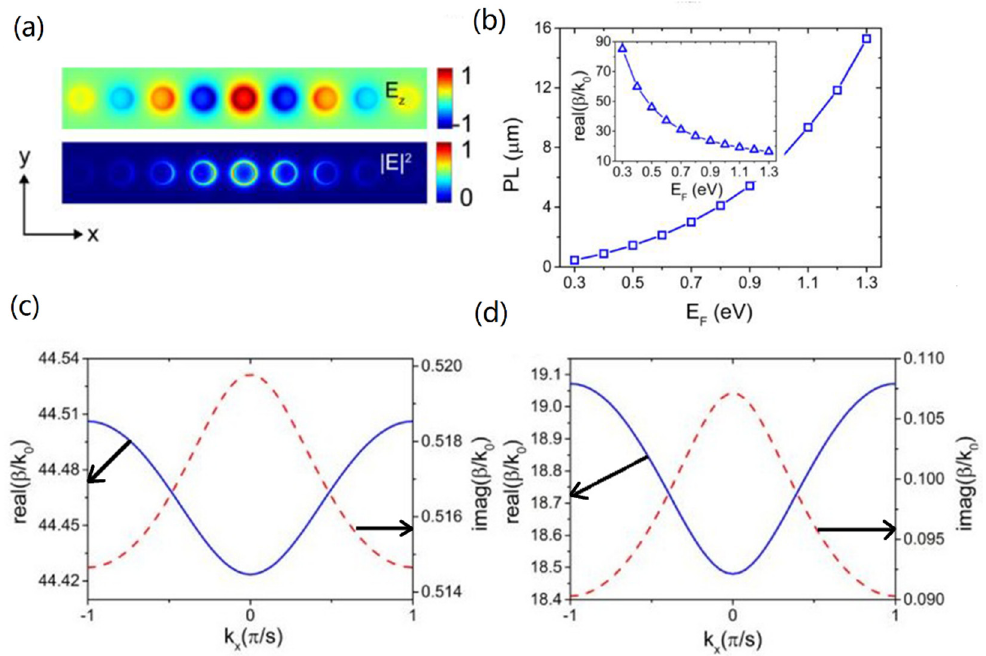
Figure 7. ( a ) Field distribution of a 1D GCNW array. ( b ) The soliton propagation length, insert for soliton mode index. Diffraction relation of the fundamental transmission band, μ c = 0.5 eV for ( c ) and 1.1 eV for ( d ). λ 0 = 10 μ m, a = 100 nm, and s = 4 a . Reprinted with permission from reference [88]. Copyright Optical Society of America, 2016.